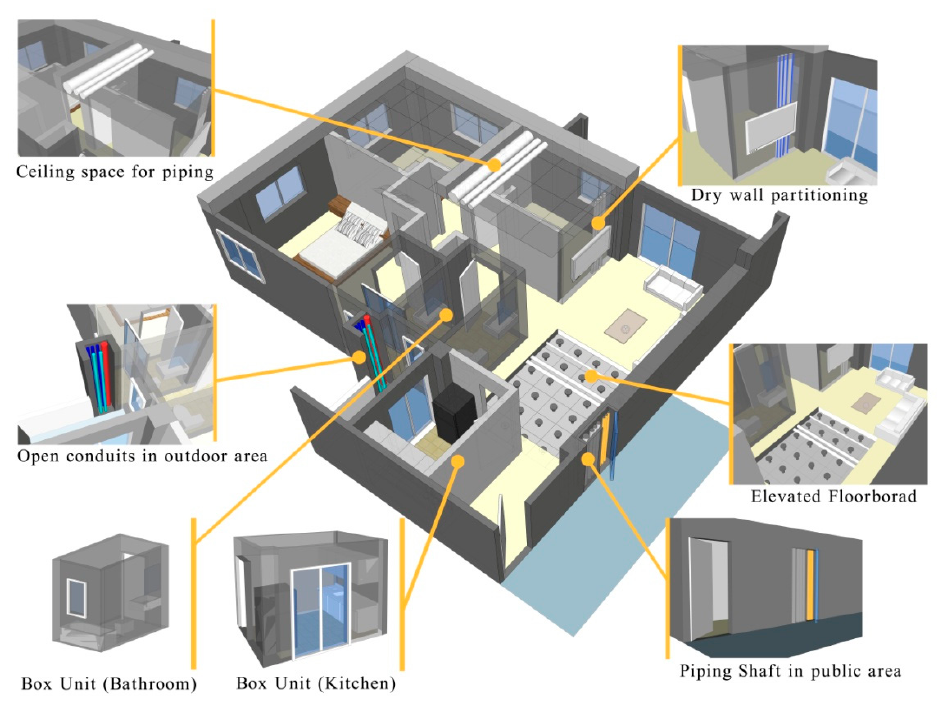
Figure 1. The open building design technologies applied in residential construction.